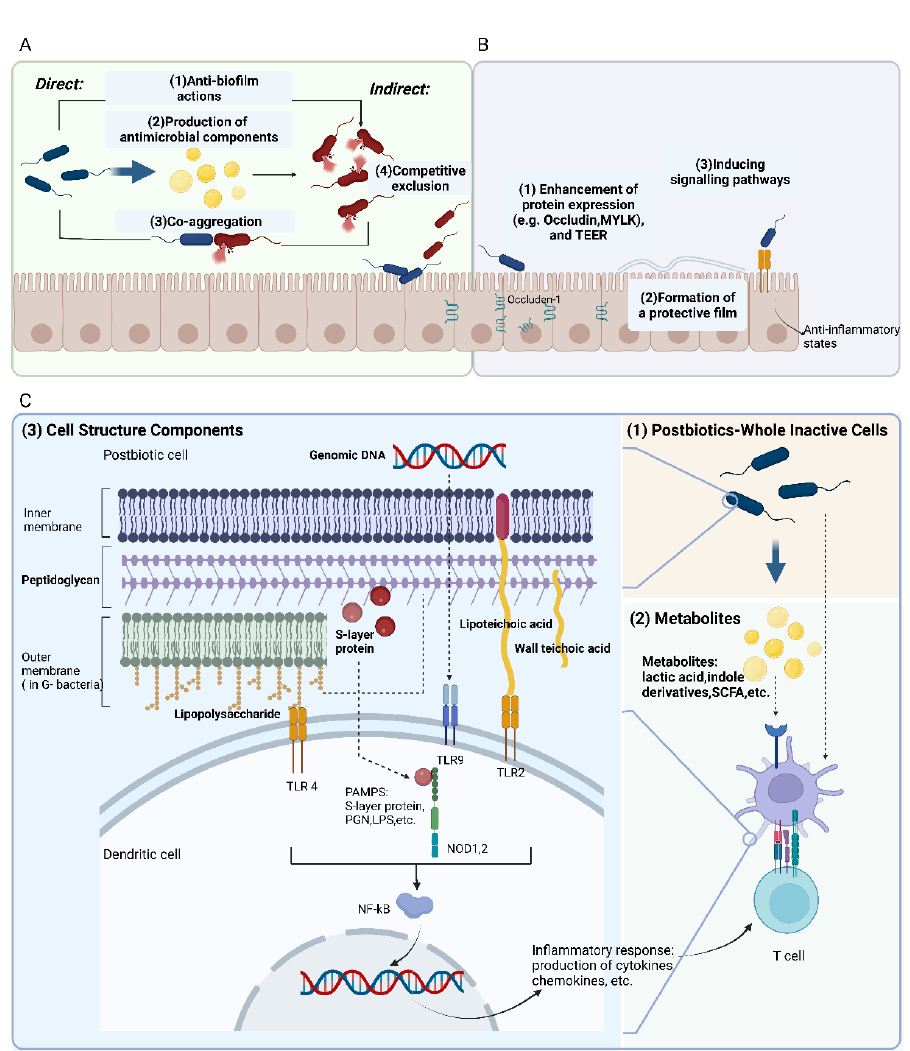
Figure 2. Predominant mechanisms of postbiotic action. ( A ). Protective modulation against pathogens. ( B ). Fortify the epithelial barrier. ( C ). Modulation of immune responses. (figure was created with Biorender. com).